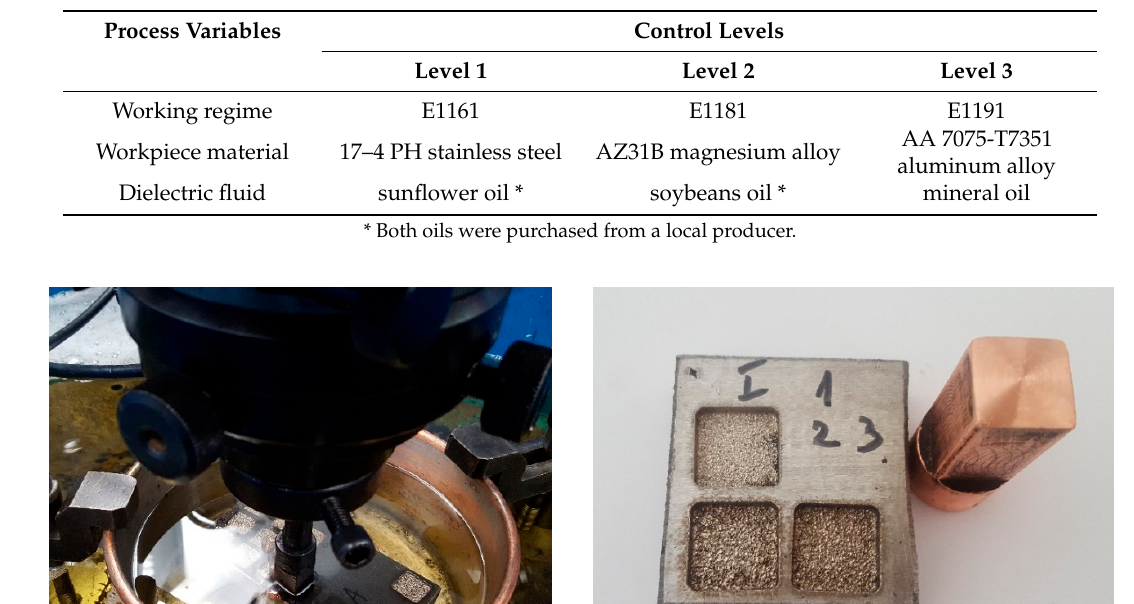
Table 1. Process variables and their control levels.